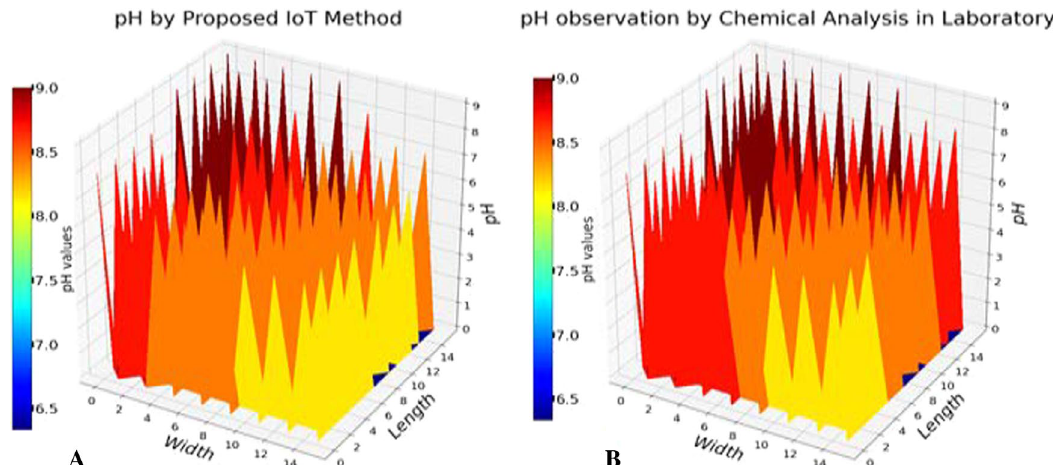
Fig. 10 pH observations